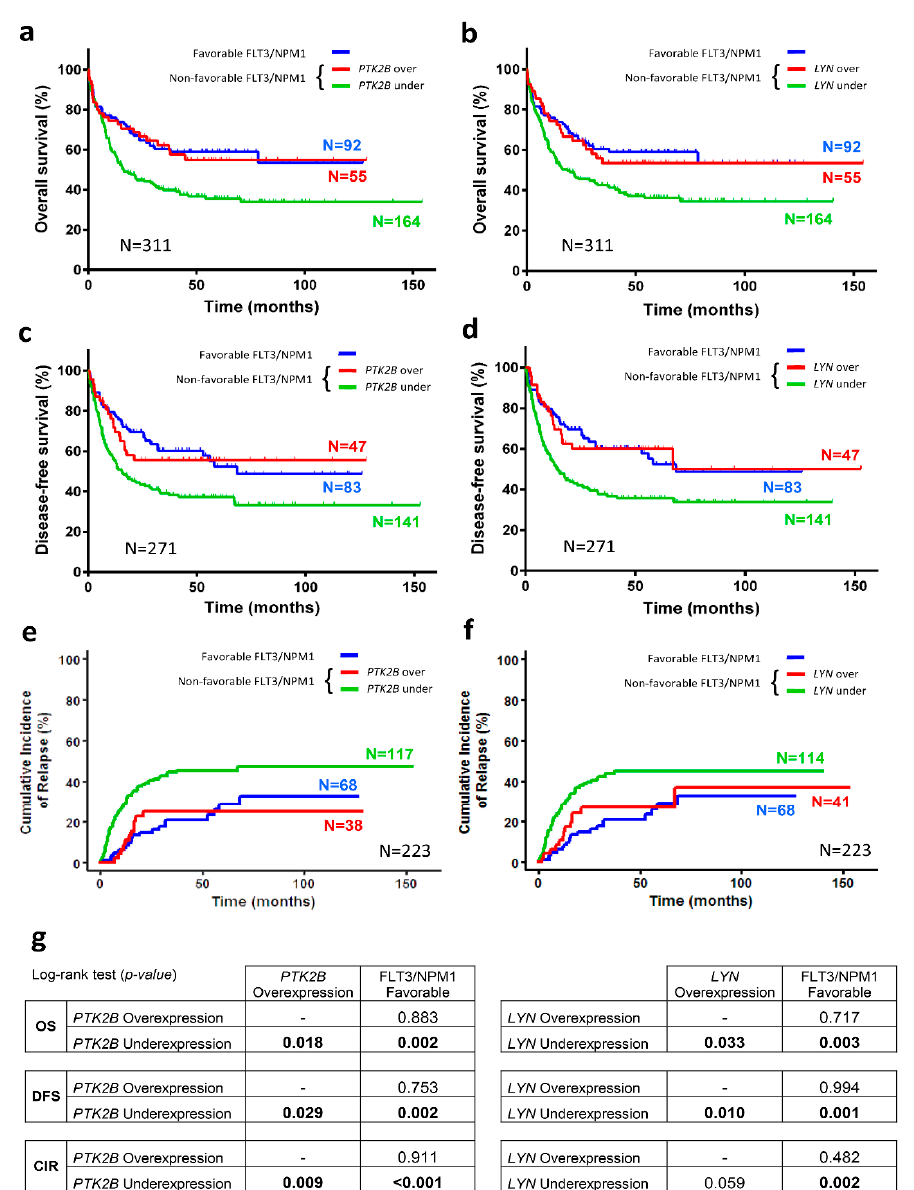
Figure 4. PTK2B or LYN overexpression identifies a subgroup of patients with cytogenetic IR-AML and non-favorable FLT3/NPM1 combinations that show favorable OS, DFS and CIR. Kaplan-Meier curves represent survival depending on the PTK2B ( a , OS; c , DFS; e , CIR) or LYN ( b , OS; d , DFS; f , CIR) expression. Red line and green line indicate PTK2B or LYN overexpressed and underexpressed, respectively. Blue line indicates favorable FLT3/NPM1 combination prognosis. Log-rank test for OS and DFS, and Gray test for CIR were used to analyze the statistical significance and are represented in the table ( g ). p < 0.05 was considered statistically significant (bold values).